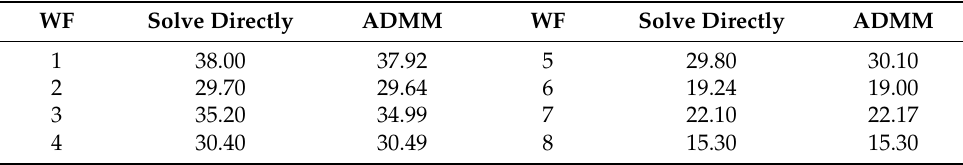
Table 2. Comparison of centralized and distributed algorithm